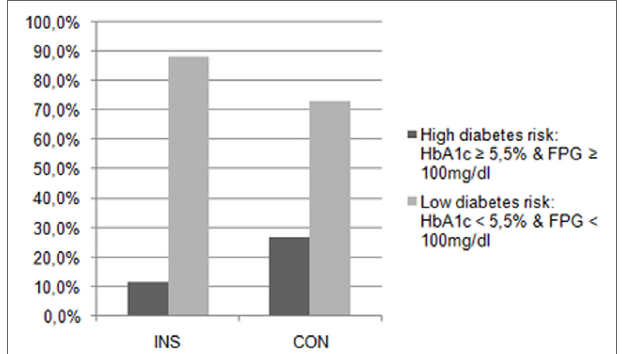
FigUre 1 | Diabetes risk in patients with insomnia (INS) and in the control group (CON). The patients with insomnia showed no significantly higher risk for diabetes than the controls.